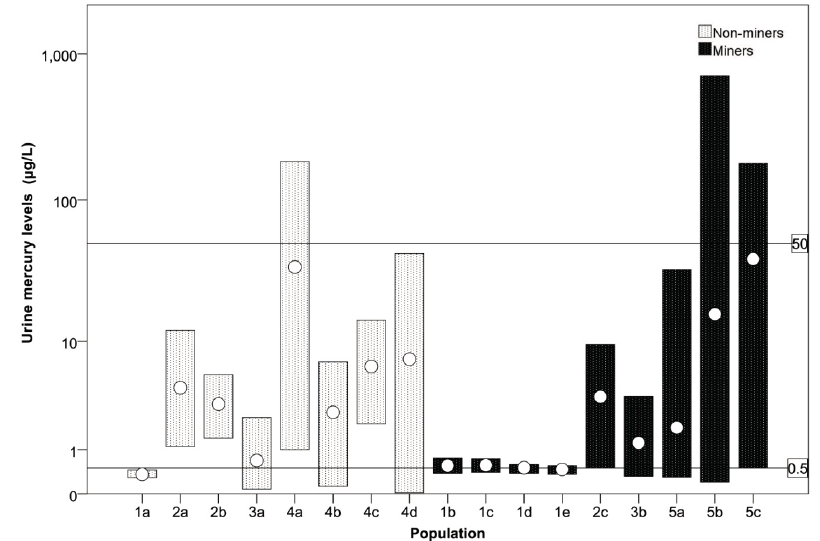
Figure 4. Urinary mercury levels (µg/L) from miners and non-miners across Ghana. For a given population (see key below), the bars represent the measured range while the circles represent the mean. Lines represent the WHO guideline value of 50 μ g/L for occupational exposure [37], and 0.5 μ g/L, the average mercury concentration in urine for the U.S. population [38]. The population numbers refer to various studies as follows.